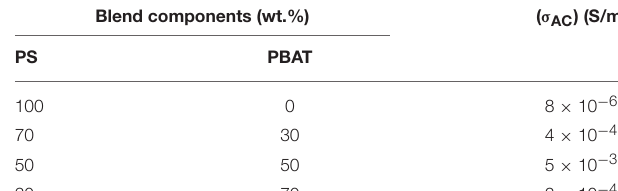
TABLE 2 | σ AC of PS/PBAT blends with different compositions and loaded with 0.66 wt.% of CNT. Blend components (wt.%)